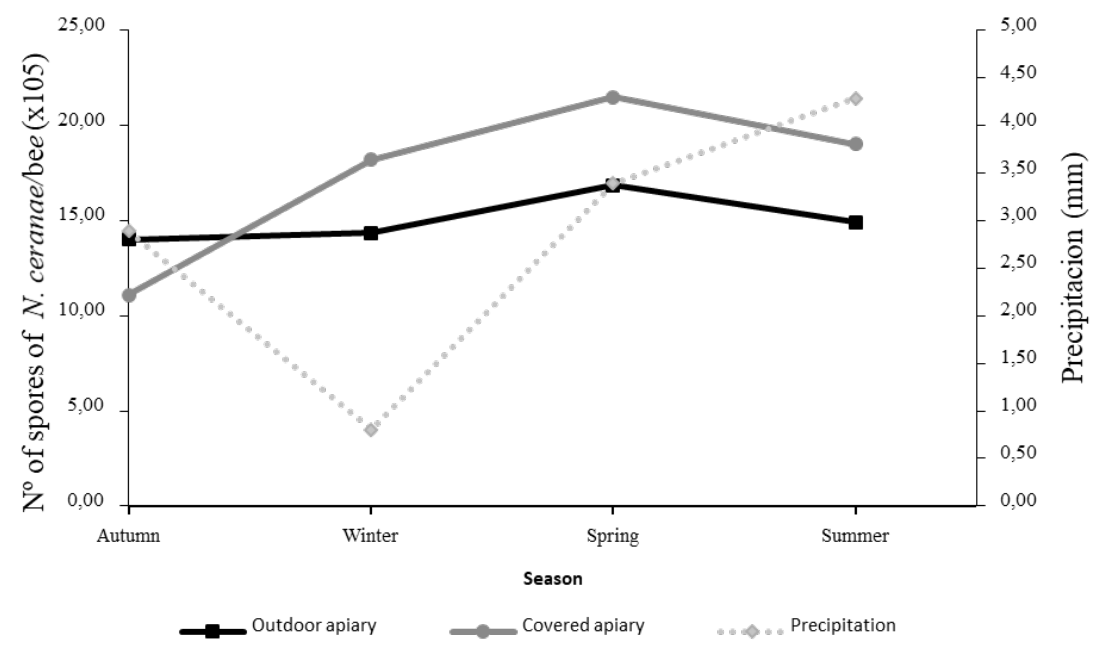
Fig 5 . Intensity of natural infection of Nosema ceranae (average number of spores/bee x10 5 ) and pollen production in hives located in open air apiary and covered apiary from August 2015 to August 2016 in relation to the seasons of the